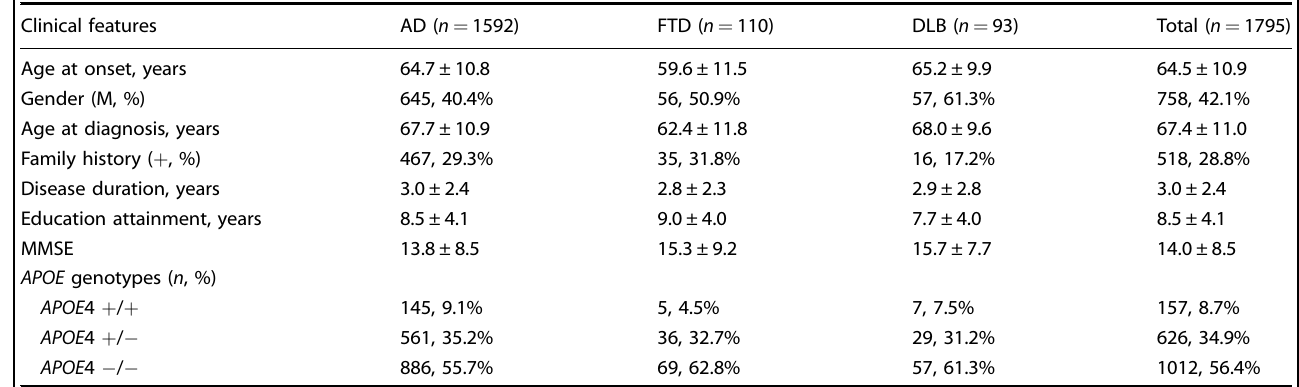
Table 1. Summary of clinical features of the cognitive impairment disease patients in this study. Clinical